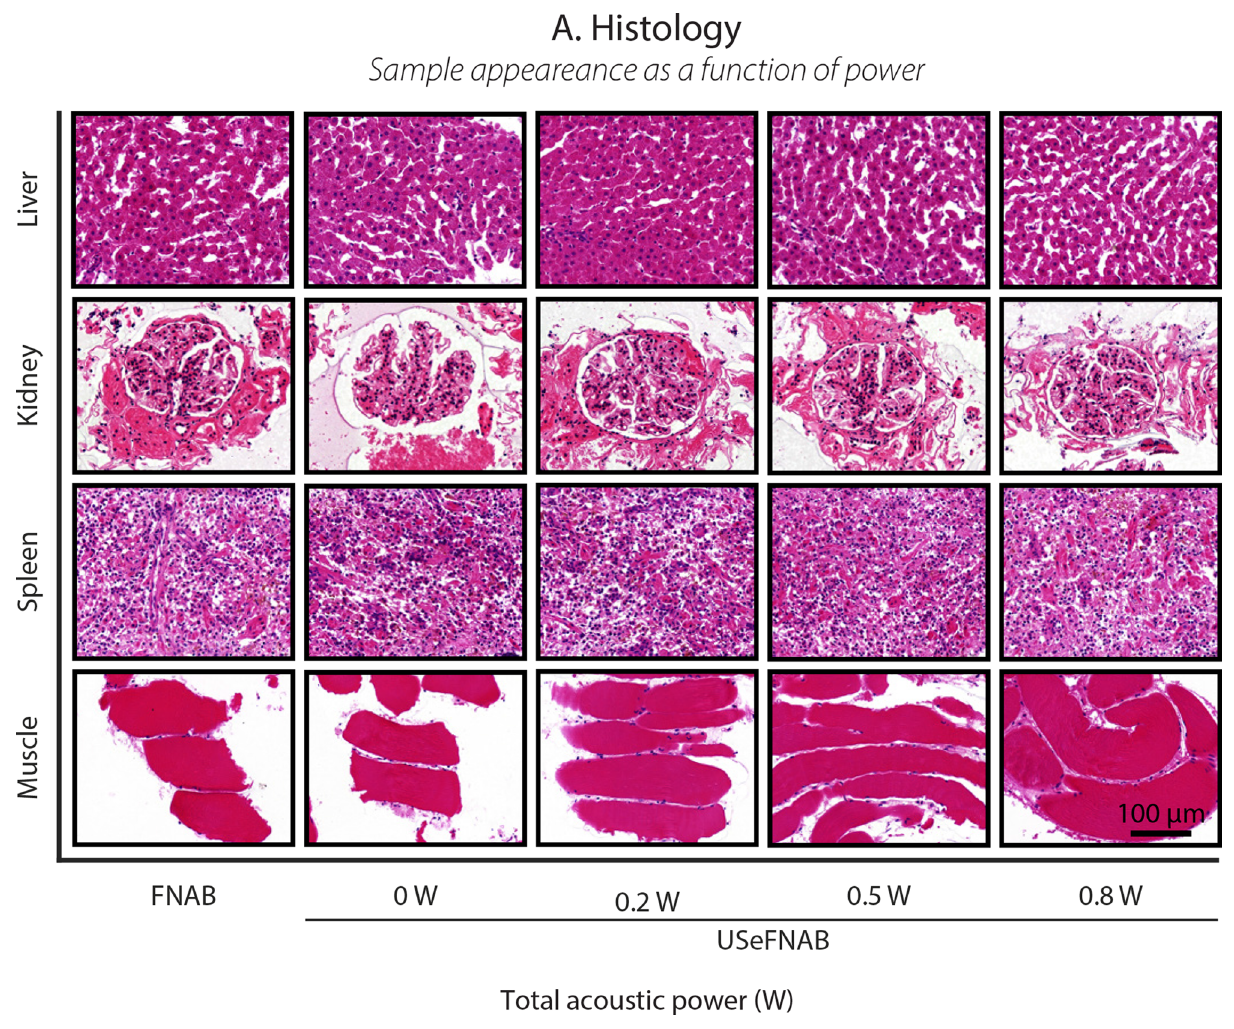
Figure 4. Histological pictures (20× magnification) of cell block sections prepared from biopsy aspirates taken from different bovine organs (top to bottom: liver, kidney, spleen and muscle) at different TAP levels (left to right: FNAB, USeFNAB 0 W, 0.2 W, 0.5 W and 0.8 W). The results demonstrated that different tissue types included histopathologically relevant cells or tissue constructs, suggesting that SonoLancet could